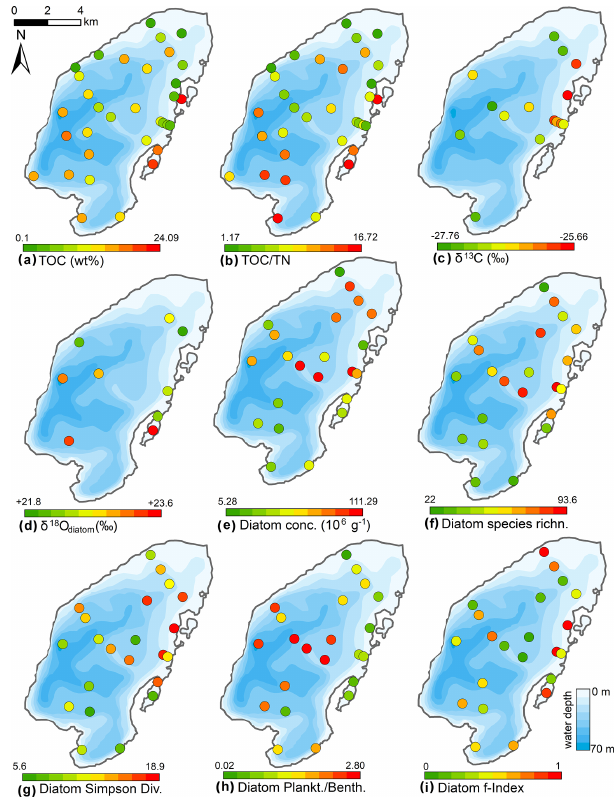
Figure 9. Spatial distribution of organic properties and statistical parameters inferred from diatom assemblages in the surface sed- iments of Lake Bolshoe Toko. Maps compiled in ArcGIS 10.4. Scales chosen as 10 classes with equal